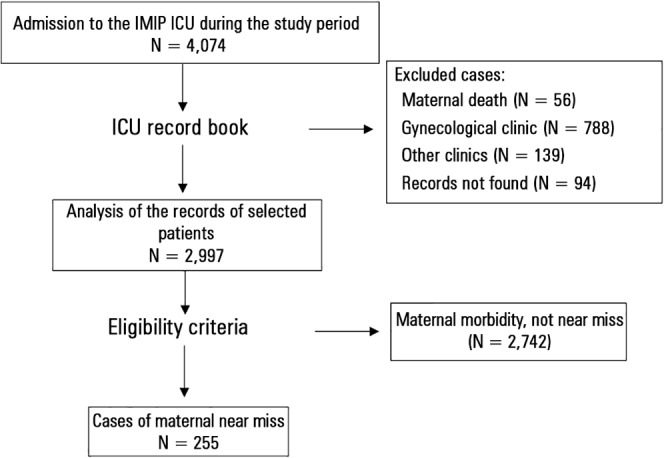
Flowchart of participant selection.ICU - intensive care unit; IMIP - Instituto de Medicina Integral Professor
Fernando Figueira.